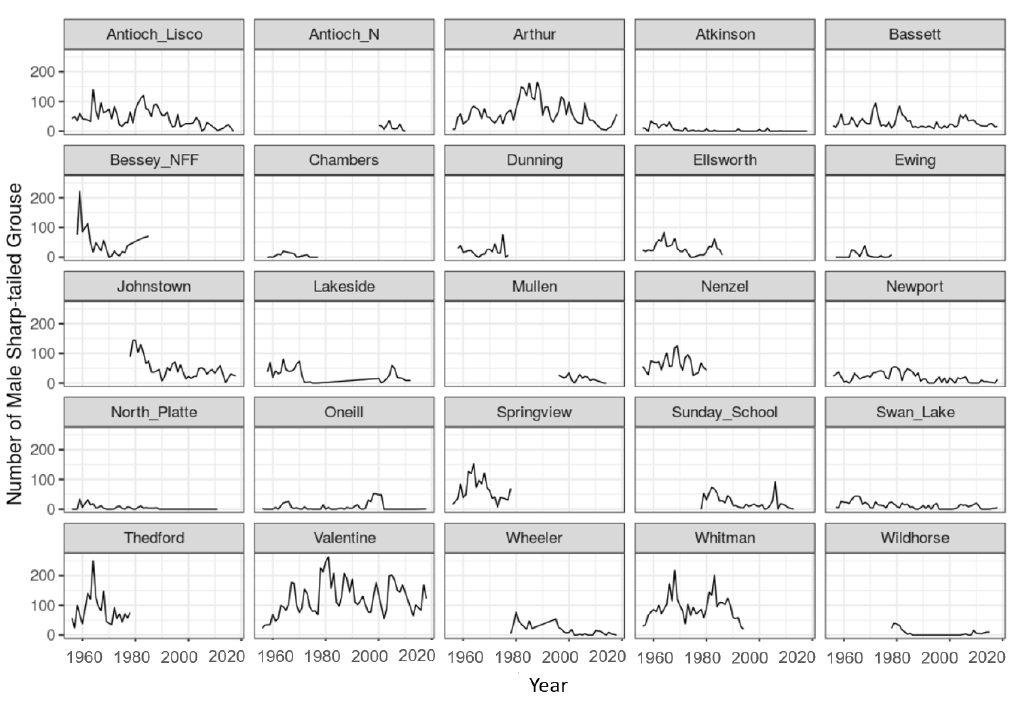
Figure A1. Sharptail spring breeding ground counts by 20-mile route from 1956 to 2018 for 25 historical survey transects in the Sandhills of Nebraska, USA.